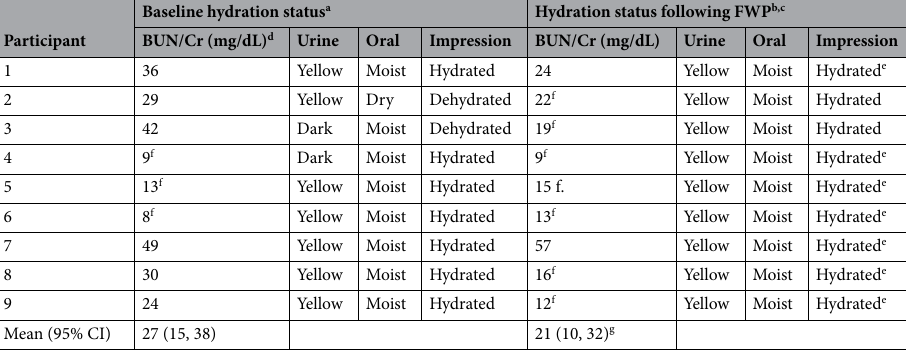
Table 4. Hydration status. a Collected prior to the baseline period days 1–3; b Collected following the FWP period days 5–7; c FWP free water protocol; d BUN/Cr blood urea nitrogen/creatinine; e No change in overall hydration status; f BUN/Cr falls within normal limits of 6 – 22 mg/dL; g Not significantly different to baseline; mean (95% CI) difference = − 6 (− 14, 2), P = 0.1406.